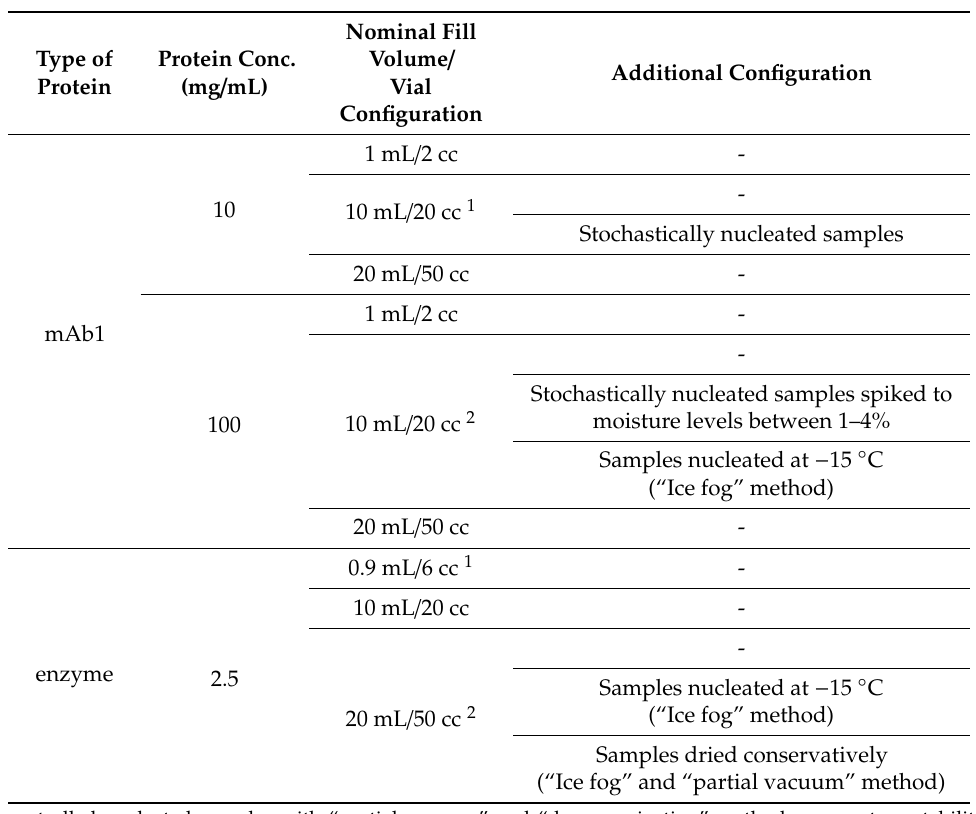
Table 1. Overview of sample preparation. Samples were manufactured with each nucleation